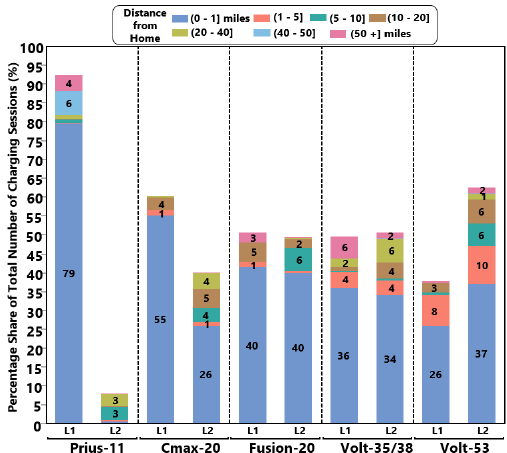
Figure 10. Percentage share of L1 and L2 charging sessions by distance from home. Values less than or equal to 1% have been omitted for clarity. Distances are the great-circle distances calculated using the Haversine formula.